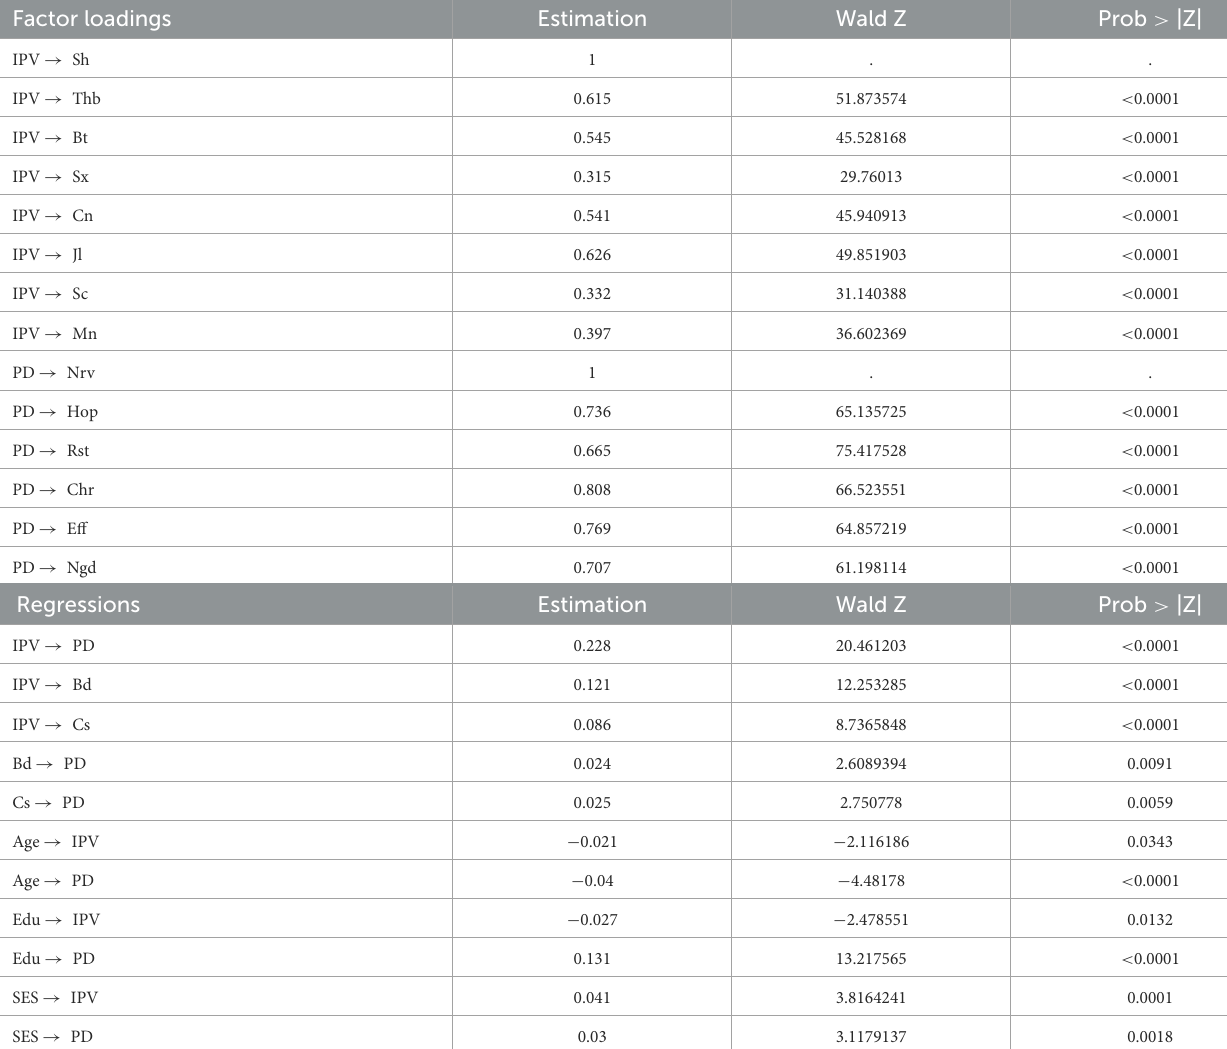
TABLE 4 Structural equation model between IPV and PD mediated by Bd and Cs: standardized parameters in men. Factor loadings